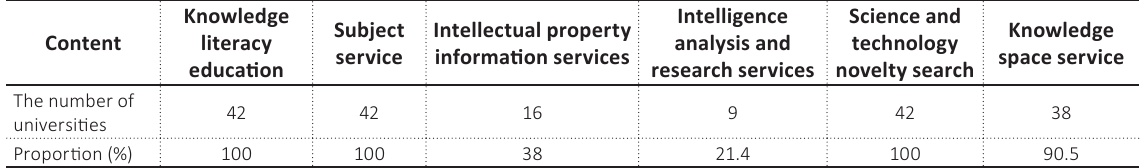
Table 3. Marketing and promotion of knowledge service content of “double first-class” university library